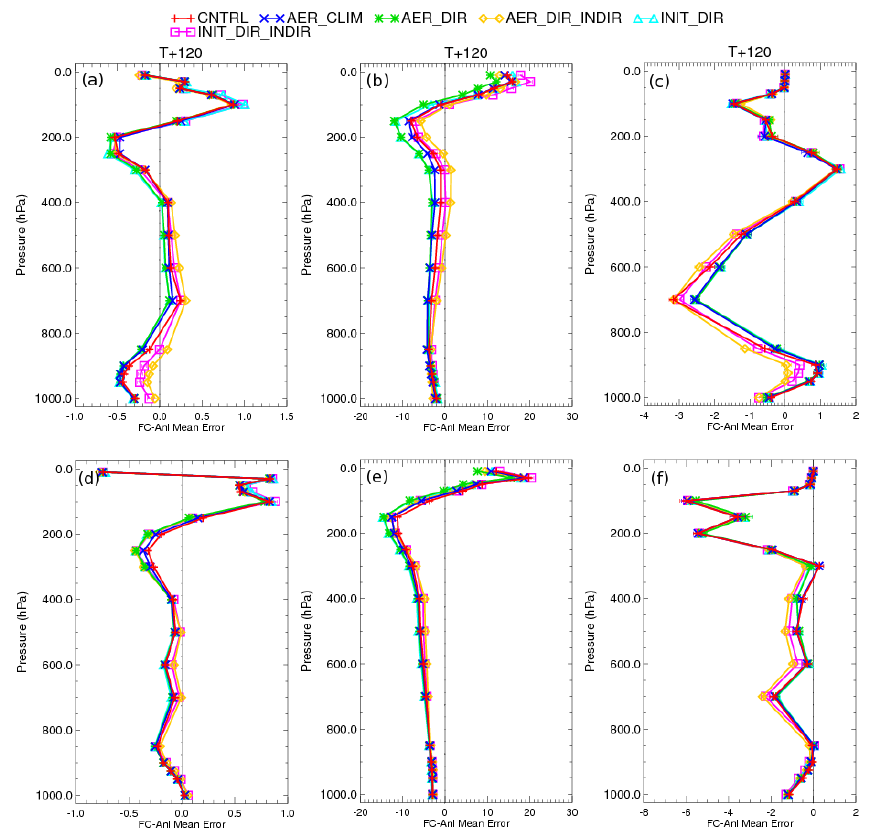
Fig. 13. Model verification of (a, d) temperature, (b, e) height and (c, f) relative humidity against analysis at T + 120 for the (top row) Northern Hemisphere and (bottom row) the tropics from all model